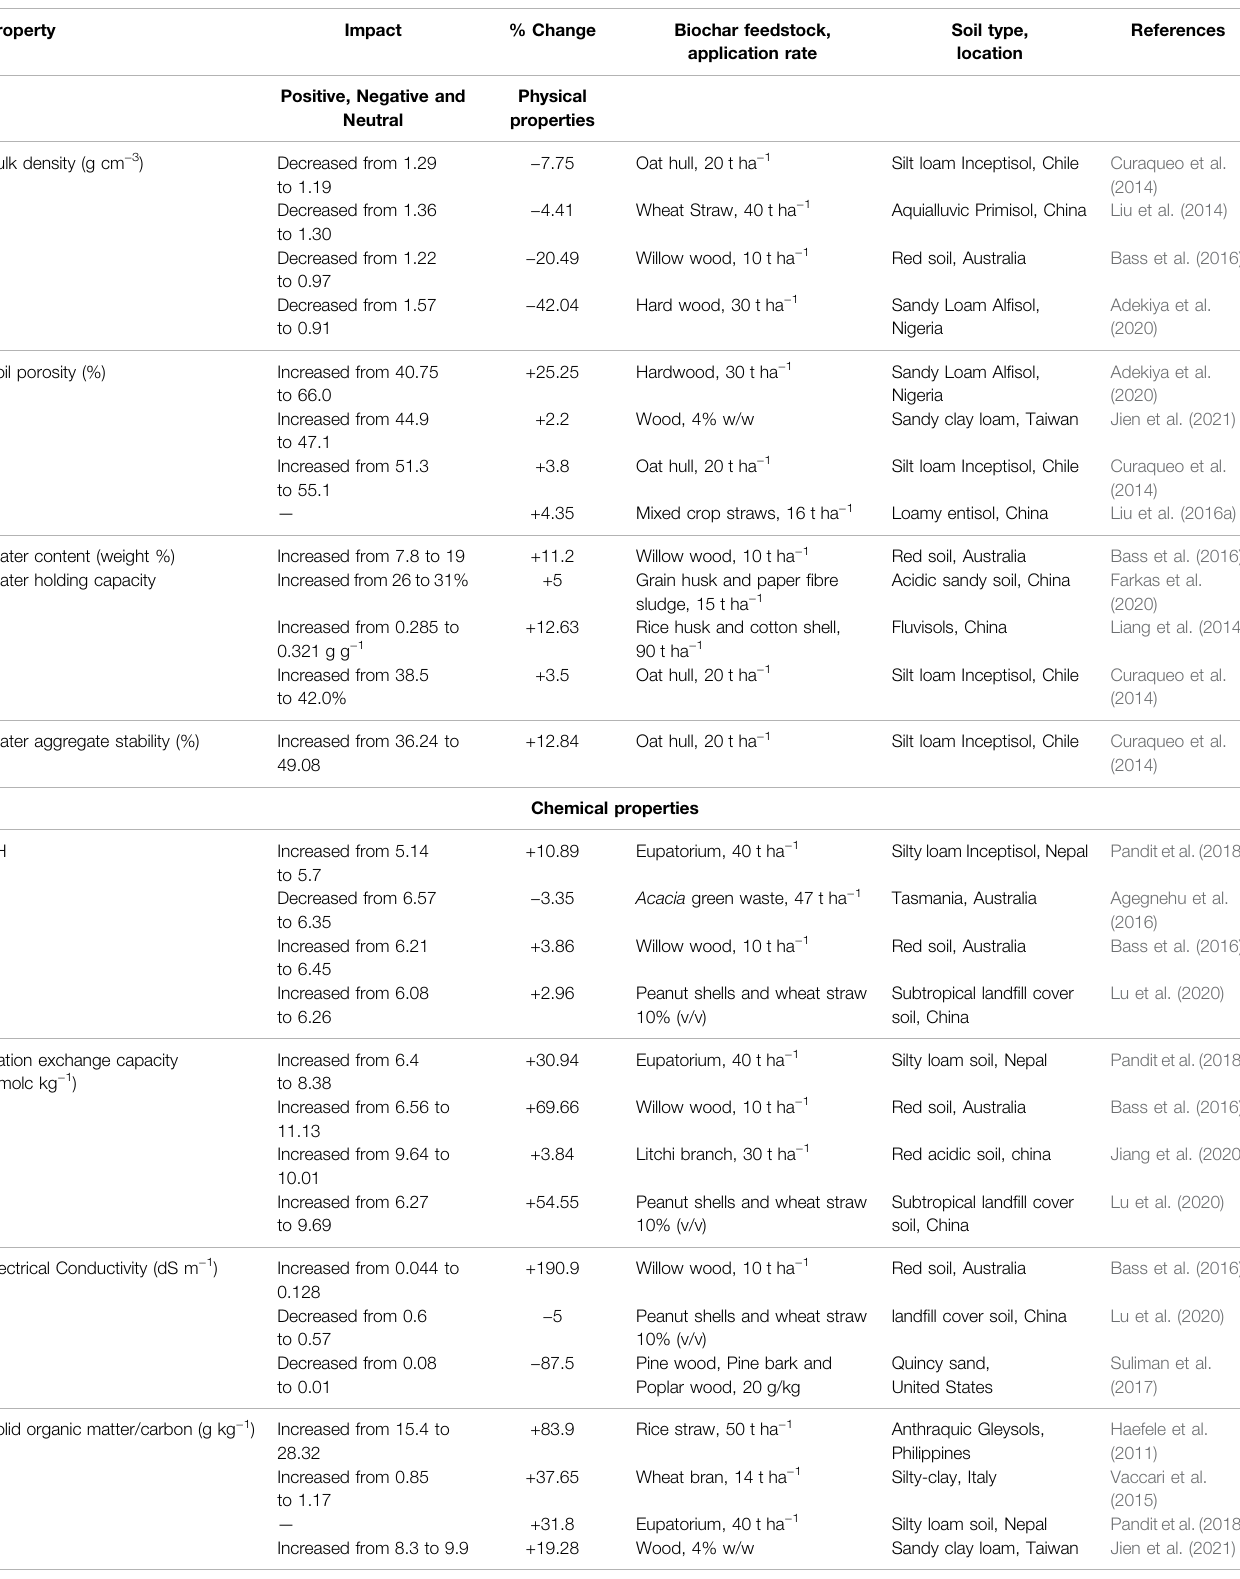
TABLE 1 | Quantitative impact of biochar application on physical, chemical and biological properties of soils from fi eld trials.